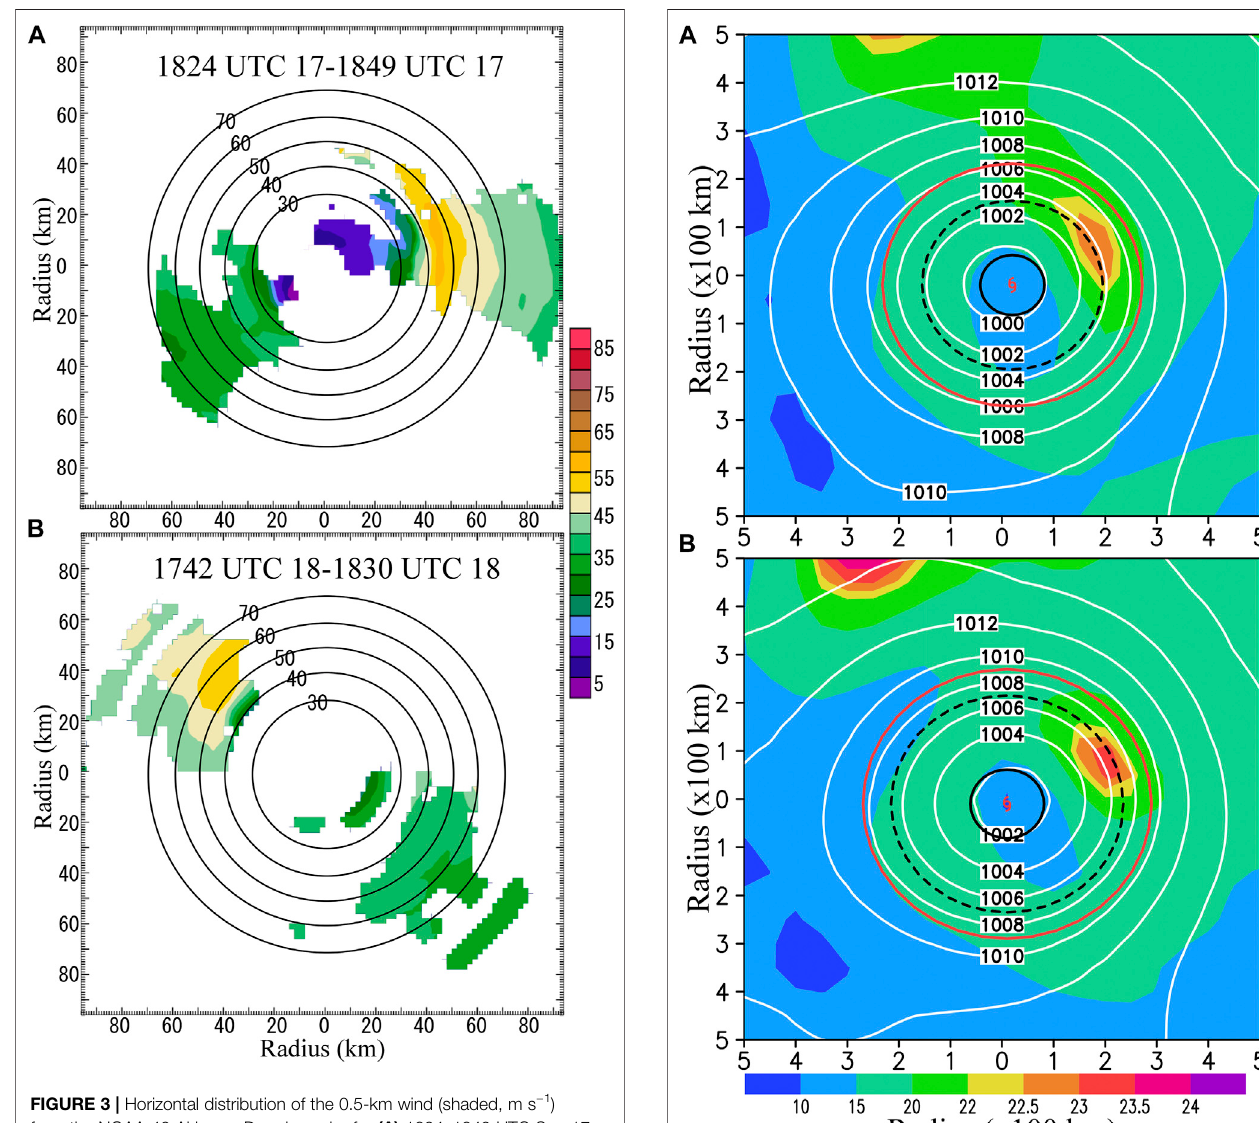
Frontiers in Earth Science |